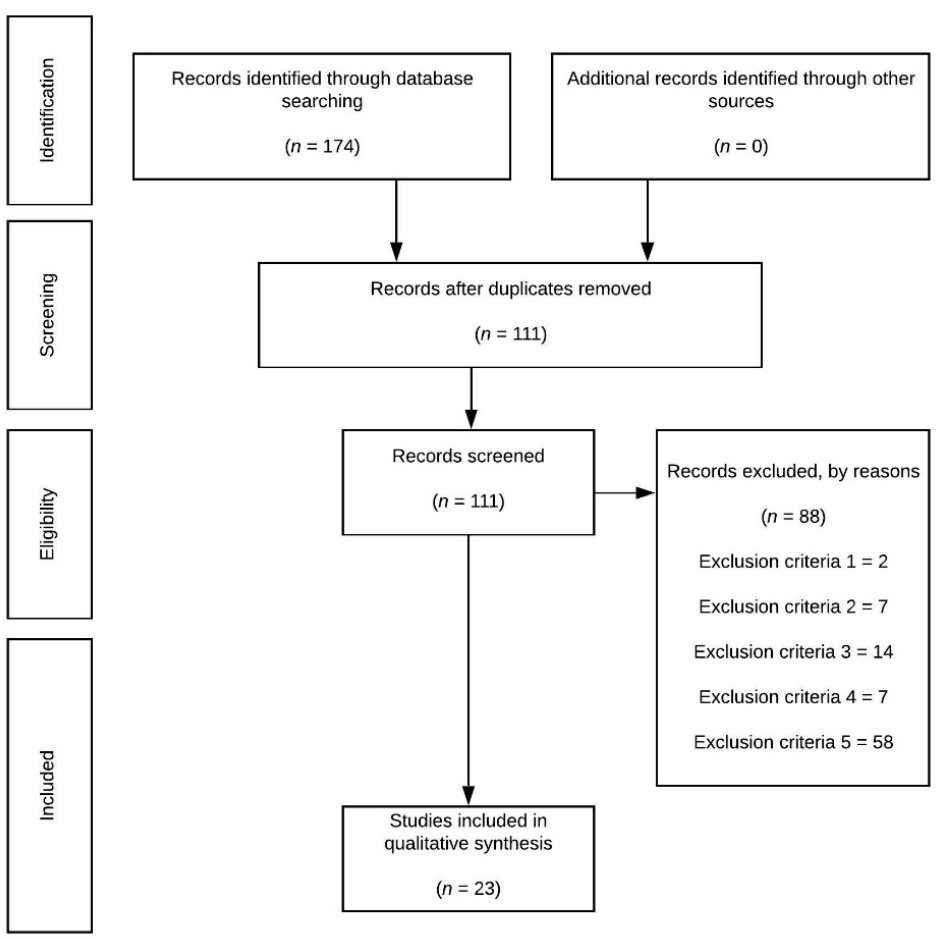
Figure 1. Figure 1. Flowchart.